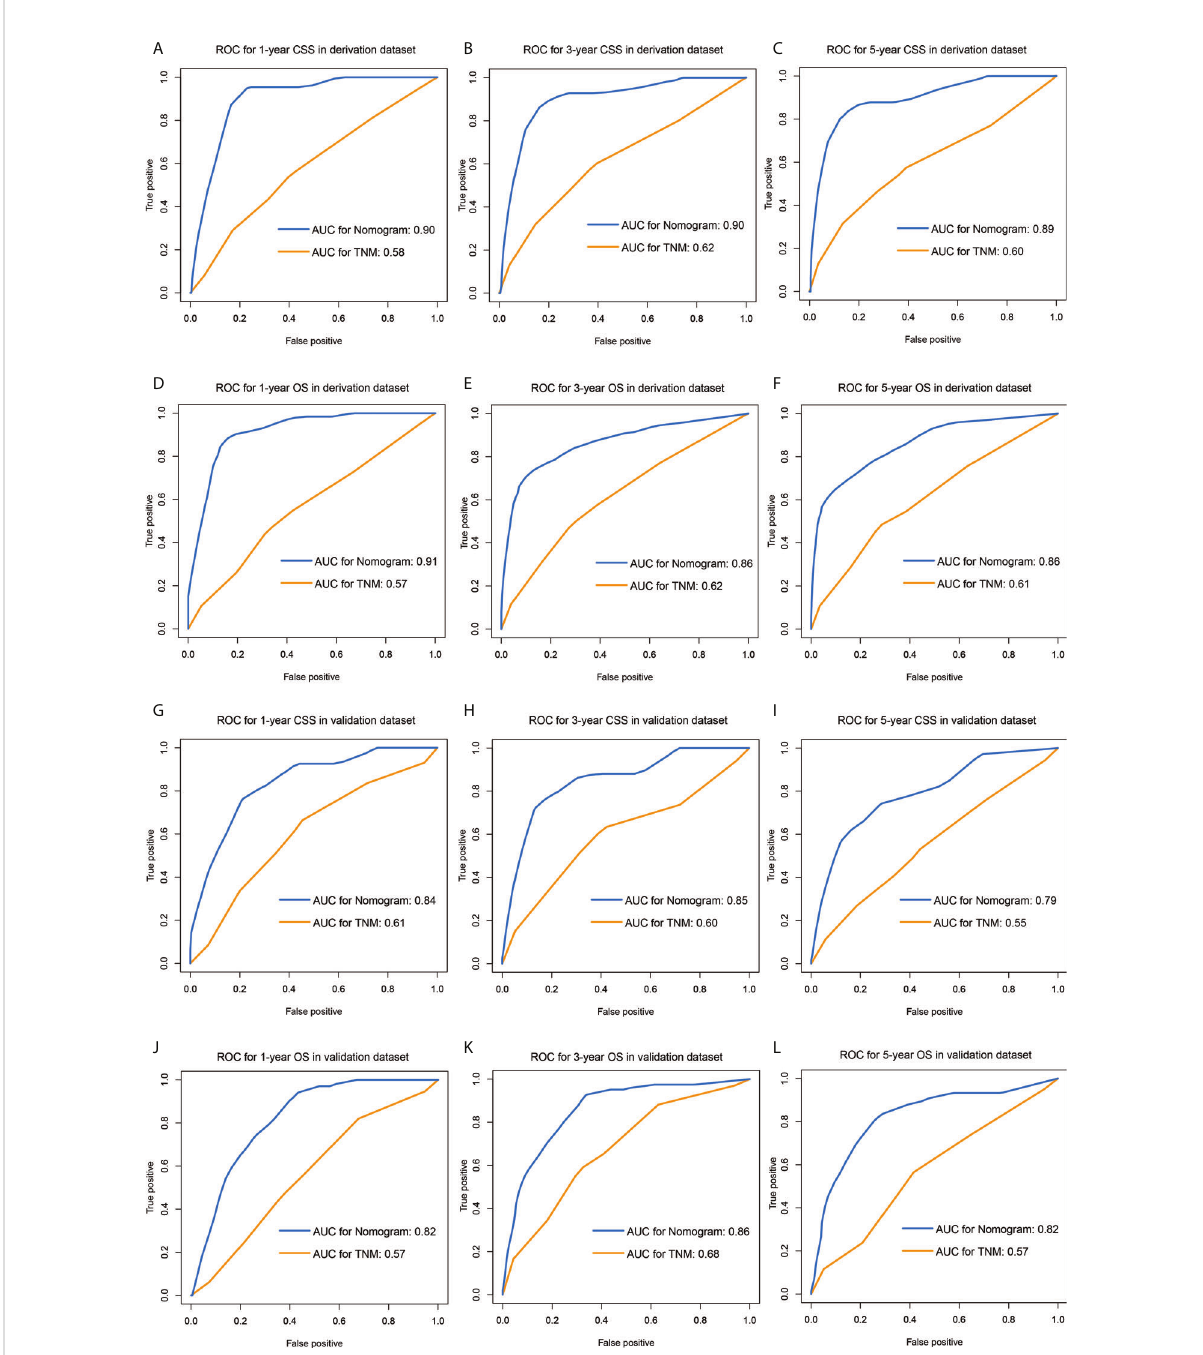
FIGURE 4 ROC curves of the nomograms and TNM staging system for predicting 1-, 3-, 5-year CSS in the derivation dataset (A – C) and external validation dataset (D – F) , and 1-, 3-, 5-year OS in the derivation dataset (G – I) and external validation dataset (J – L) . ROC, receiver operating characteristic; CSS, lung cancer-speci fi c survival; OS, overall